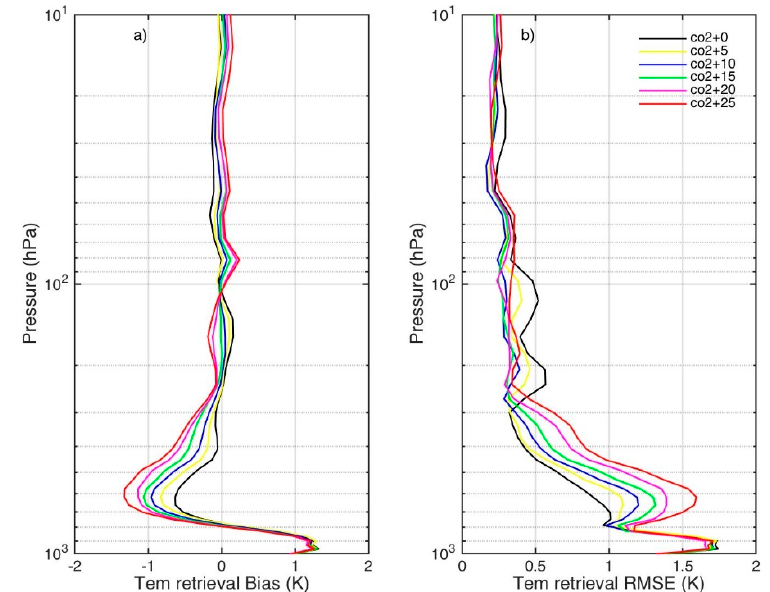
Figure 5. ( a ) Mean temperature retrieval bias and ( b ) root-mean-square error (RMSE) in different cases of CO 2 concentration perturbations. CO 2 + 0 means no IASI radiance simulation bias from CO 2 .